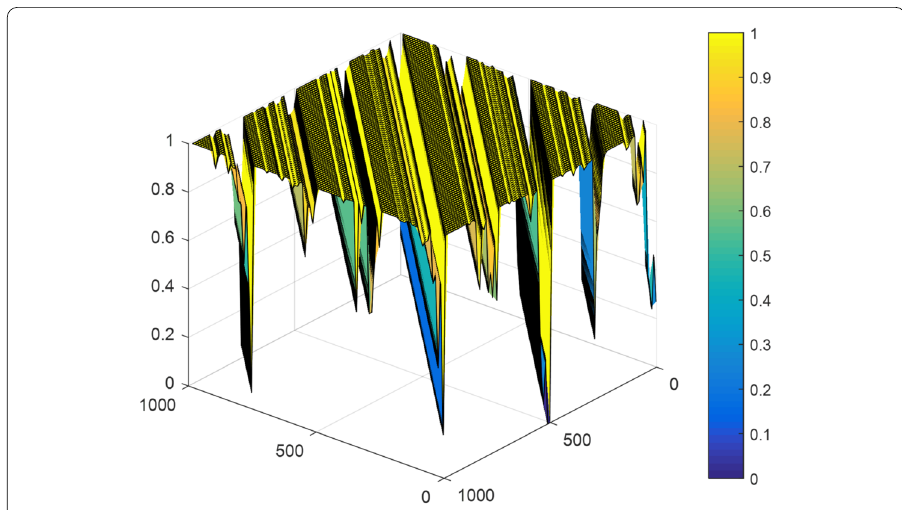
Figure 2 Power properties of FFFFF-FI-ADF %5 nominal significance level